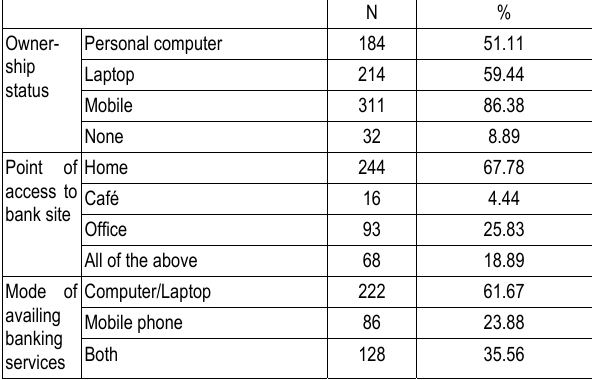
Table 2. Distribution of the sample customers by their technological utilization